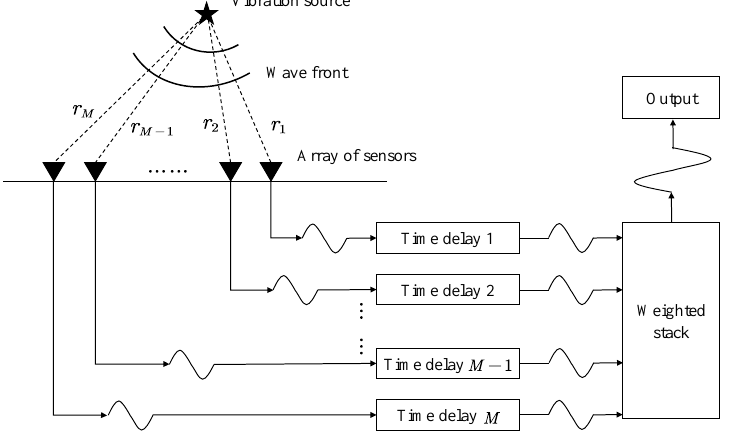
Figure 3. Schematic diagram of the beamforming technique. By compensating the arrival time difference of the same signal on different sensors, and then weighting and summing all the signals, a more significant signal can be